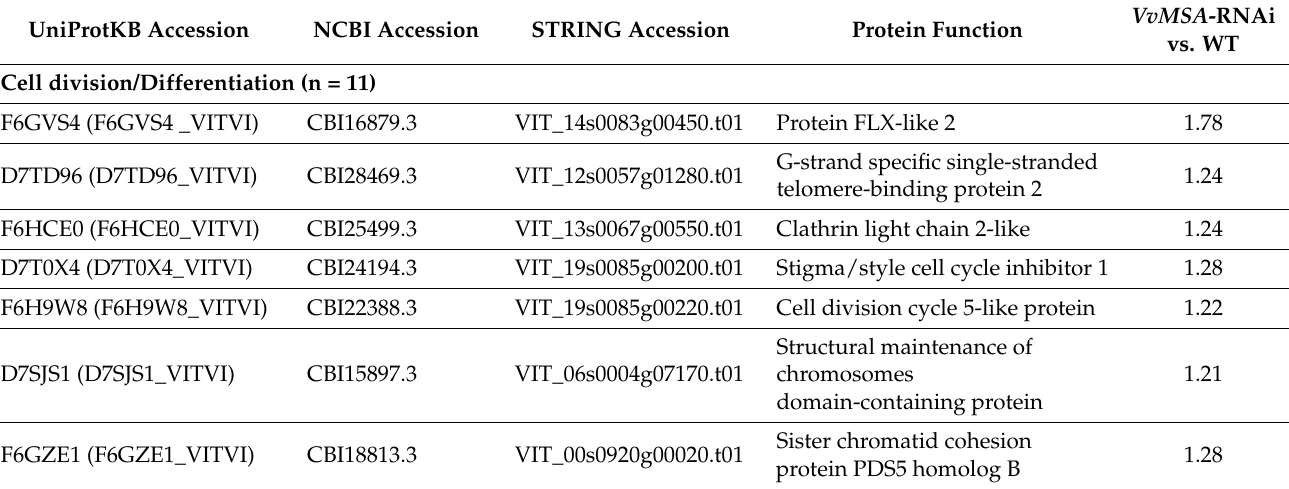
Table 1. Differentially expressed proteins in wild-type and VvMSA -RNAi grape embryogenic cells. UniProtKB Accession NCBI Accession STRING Accession Protein Function